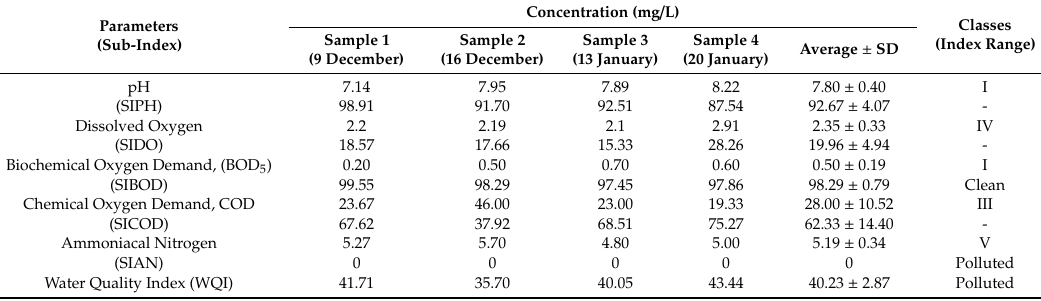
Table 9. Laboratory result (sub-index values) of river water samples upstream.